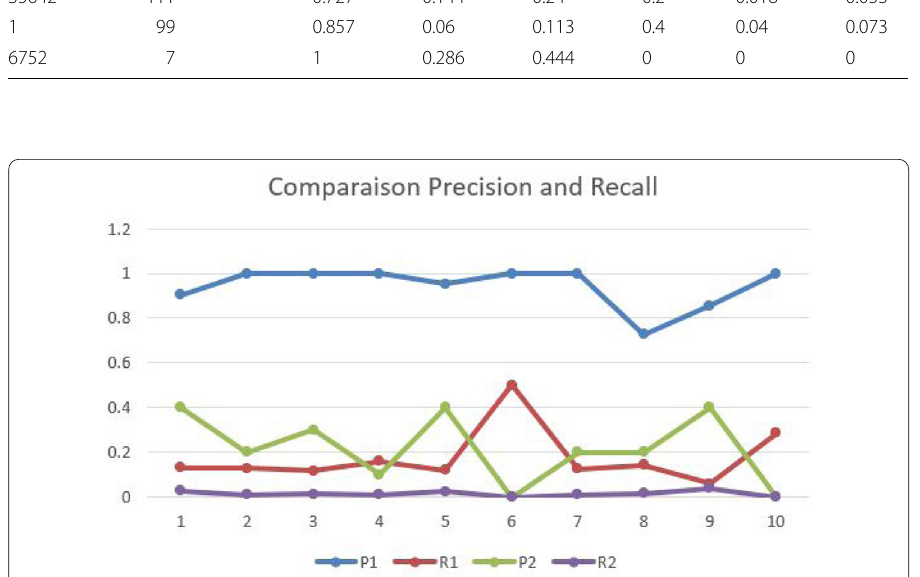
Fig. 4 Comparison of the proposed approach of folksonomy graphs based CARS with Hybrid based